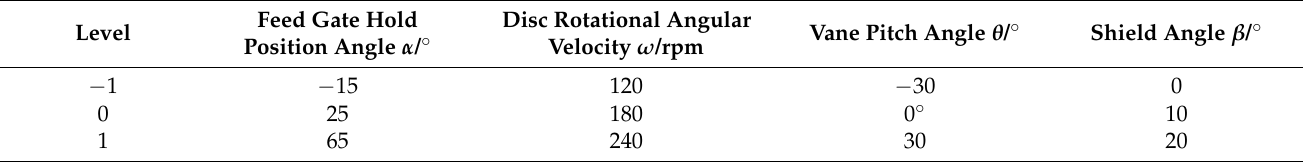
Table 3. The test codes of cross-factor